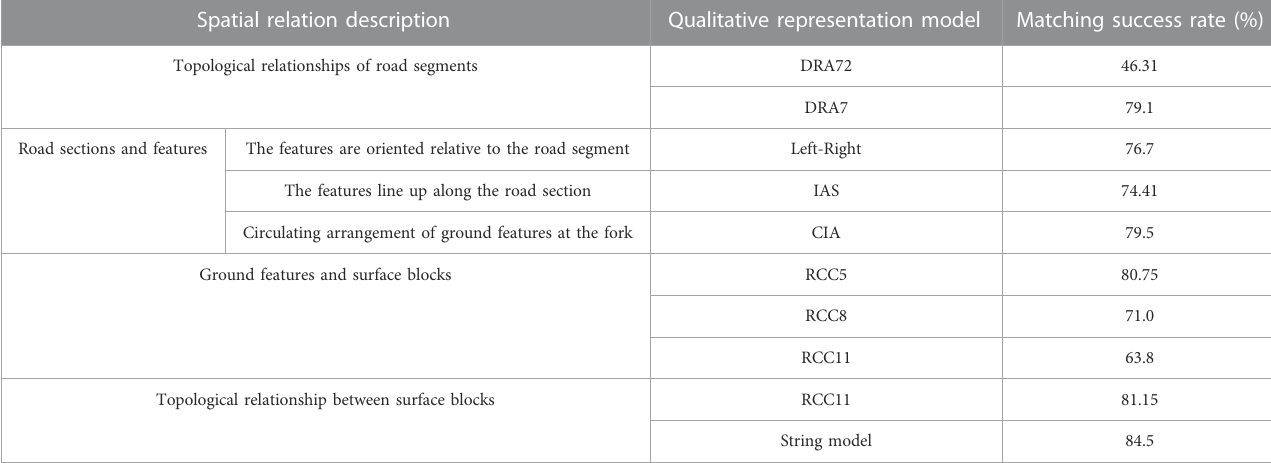
Road sections and features The features are oriented relative to the road